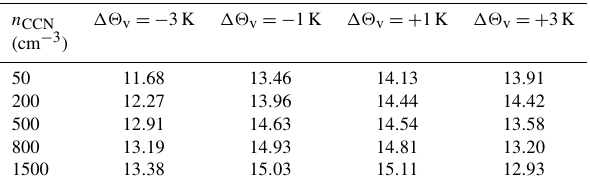
Table A1. Temperature sensitivity (in %K − 1 ) of average rainwater content RWC for all n CCN values.